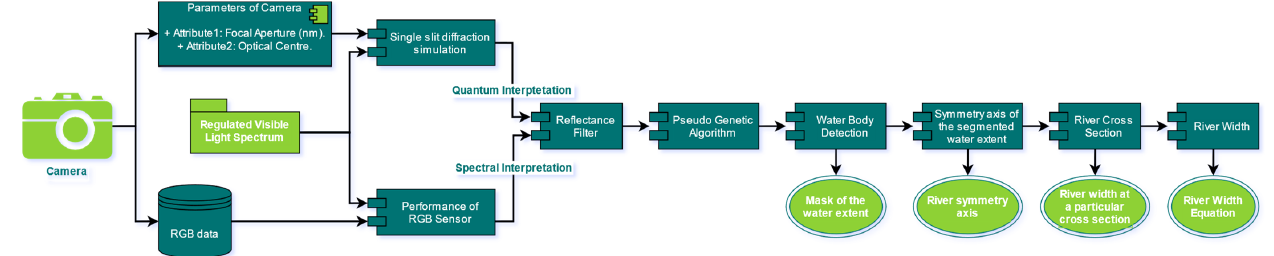
Figure 4. Schematic diagram of the modelling process from the image acquisition to the output re- sult (water body mask and geometrical characteristics such as water body area and water body pe- rimeter). Supplementary Material B presents specific details of WATER.